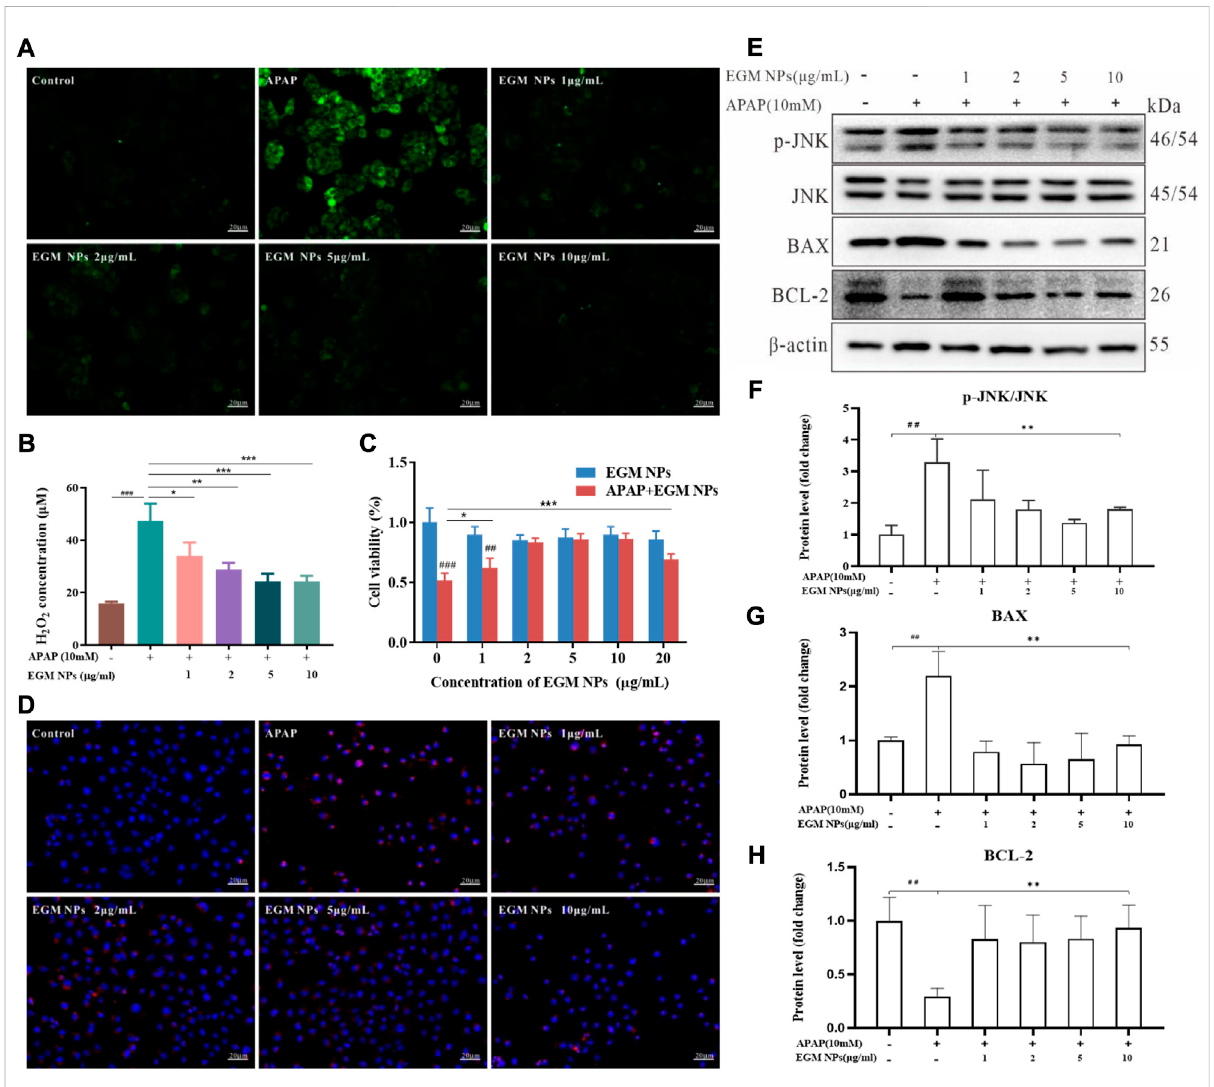
FIGURE 2 Antioxidantproperties andcellularprotectionofEGMNPs. (A) DetectionofROS generationbyDCFH-DAinL02cellsafterdifferenttreatments. Scale bar: 20 μ m. (B) H 2 O 2 concentrations generated by L02 cells after different treatments. (C) Cell viability of L02 cells after different treatments. Data represent means ± S.D. from six independent replicates. (D) Fluorescence images of MitoSOX staining in L02 cells after different treatments. Scale bar: 20 μ m. (E) Western blot analysis of p-JNK, JNK, BAX and BCL-2 proteins expression in L02 cells after different treatments. (F – H) Quanti fi cationoftheproteinimmunoblotsofp-JNK/JNK (F) ,BAX (G) andBCL-2 (H) .Datarepresentmeans±S.D.fromthreeindependentreplicates. (** p < 0.01vs . APAP group; ## p < 0.01 vs . Control